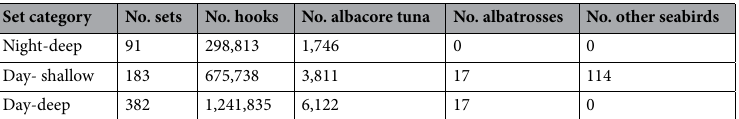
Table 1. Summary of sample sizes of three categories of set types and albacore tuna and seabird catch.